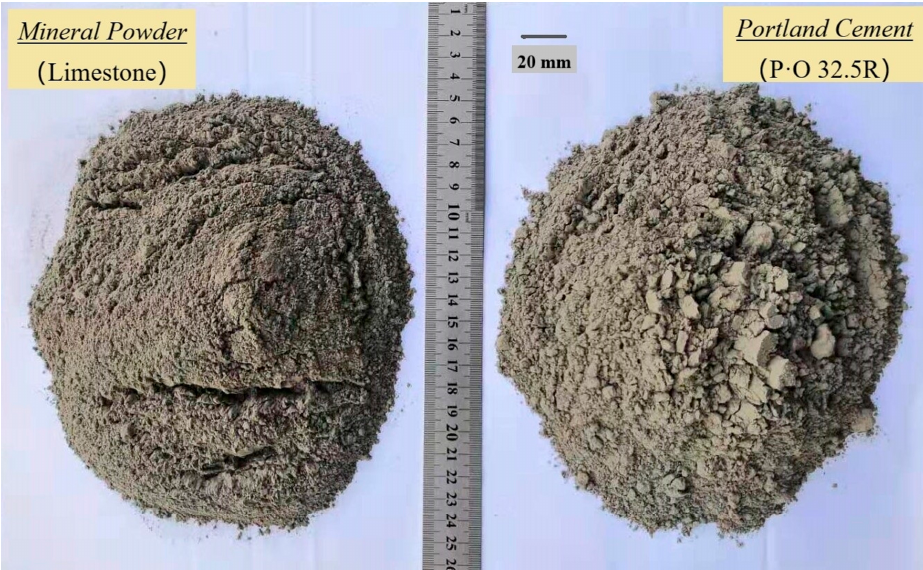
Figure 1. The appearance of the two types of fillers. Table 5. Basic properties of mineral powder and Portland cement.